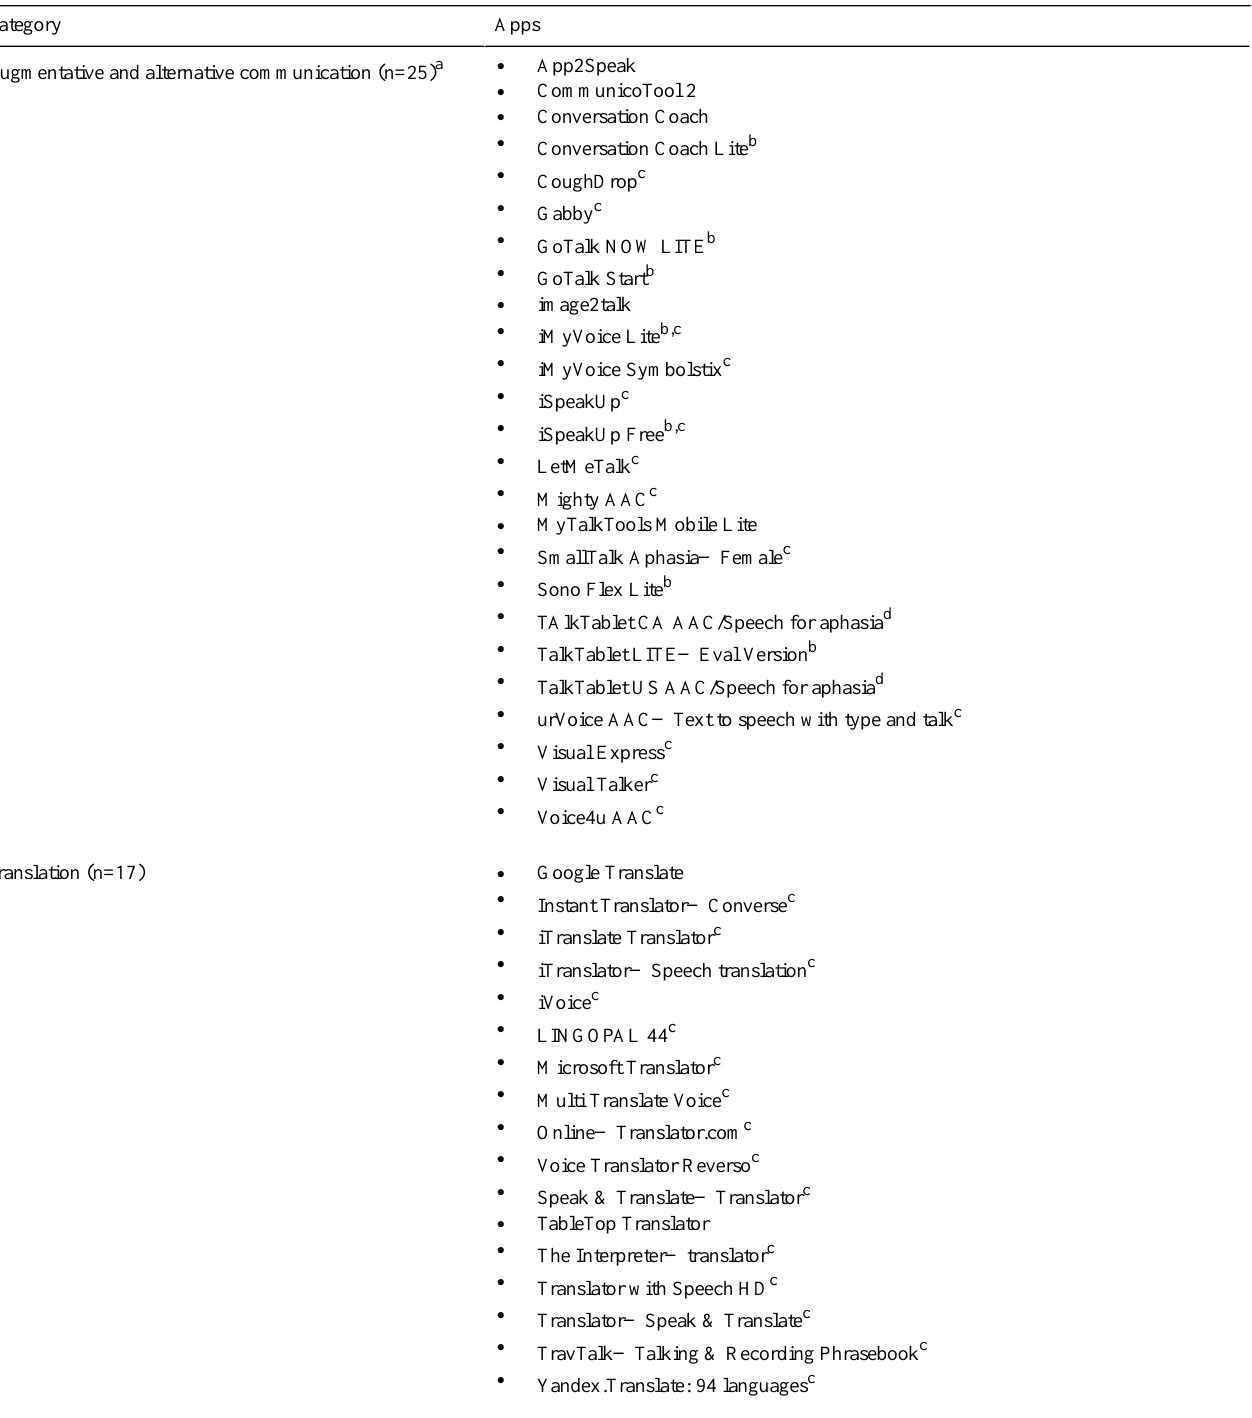
Table 4. List of communication apps evaluated in the 2017 replication